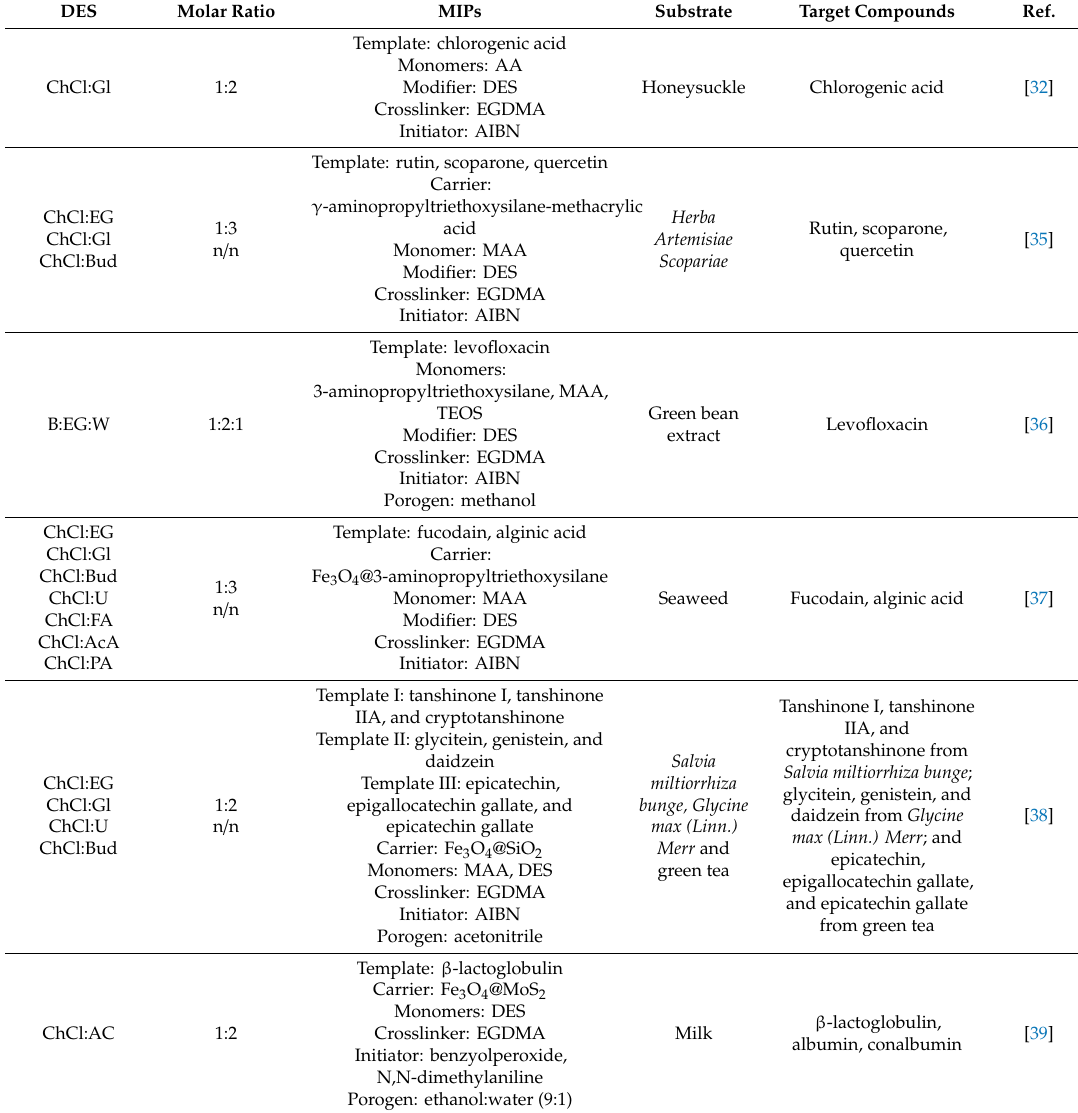
Table 1. The application of deep eutectic solvents (DESs) for molecularly imprinted polymers (MIPs) preparation and extraction / purification procedures. DES Molar Ratio MIPs Substrate Target Compounds